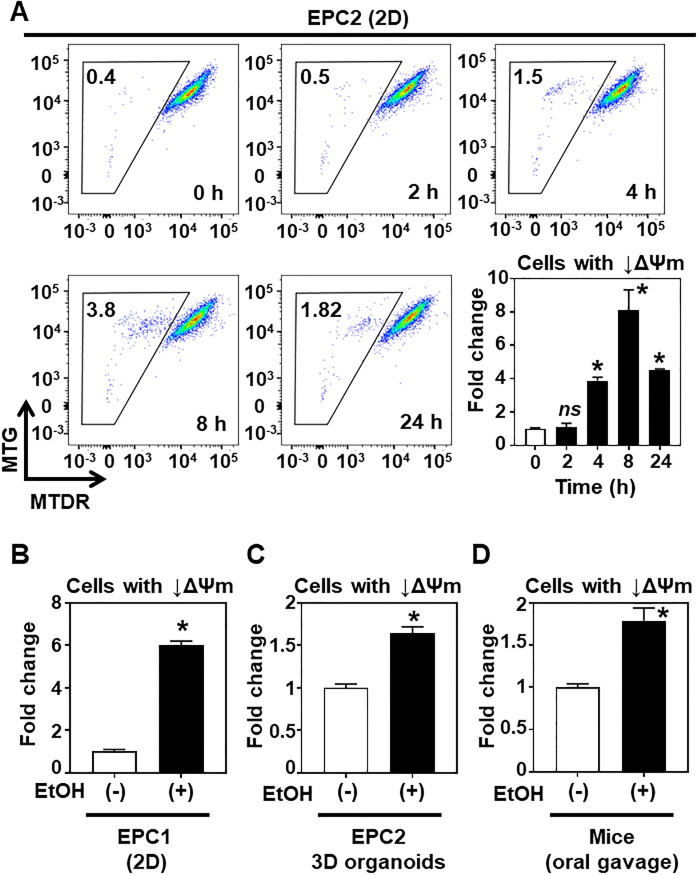
EtOH decreased ΔΨm in a subset of esophageal keratinocytes.EtOH-exposed cells were stained with MTG and MTDR for flow cytometry to determine mitochondrial mass and membrane potential (ΔΨm), respectively. A-C. Indicated cell lines were treated with 2% EtOH or untreated [EtOH (-), control] in monolayer (2D) and 3D organoid culture conditions. Representative scatter plots for MTG and MTDR at indicated time points with bar diagram (mean ± sem, n = 3 per condition) depicting quantification of cells showing reduced ΔΨm in A. Quantification of cells with reduced ΔΨm for EPC1 cells in 2D and EPC2 cells in 3D organoids are shown in bar diagrams in B and C, respectively. D. Following oral gavage with 31.5% EtOH (5 g/kg in PBS) or PBS [EtOH (-), control], mice were sacrificed 6 hours later to isolate esophageal epithelial cells for MTG and MTDR staining. Bar diagram depicts quantification of cells showing reduced ΔΨm from the murine esophagi. n = 3 per condition. *p<0.05 vs. time 0 or EtOH (-); ns, not significant vs. time 0 or EtOH (-), using student’s t-test.